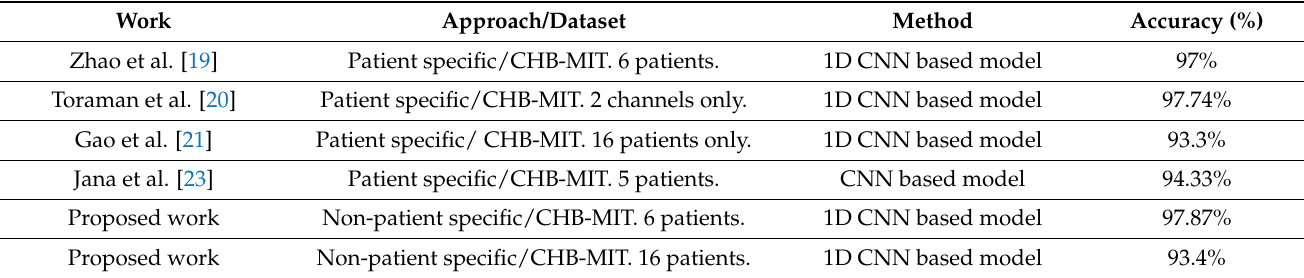
Table 10. Comparative analysis study with previous state-of-the-art work in the same domain.